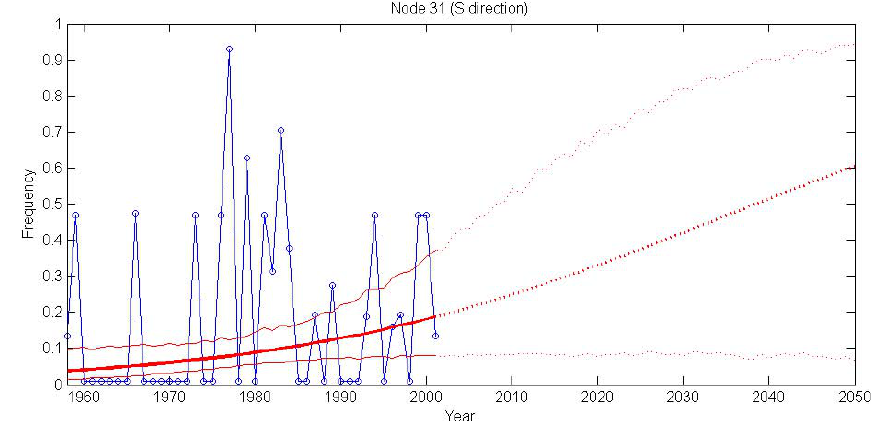
Fig. 11. Trend extrapolation of events coming from S in node 31. The figure shows the 95% confidence